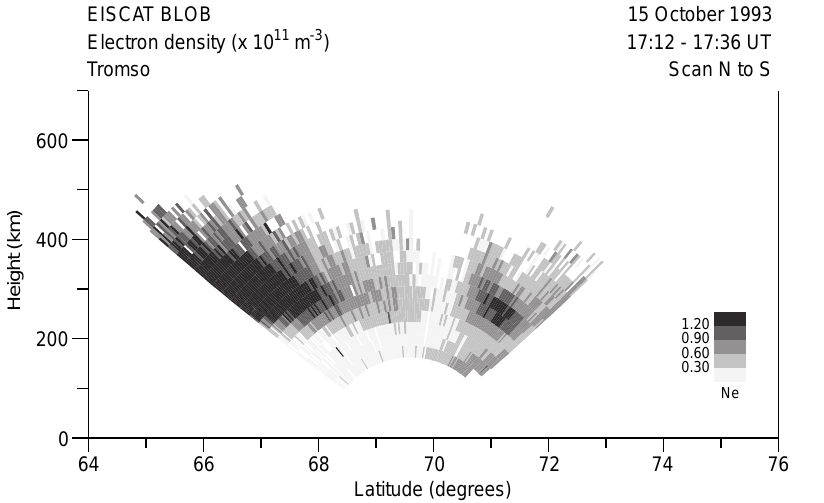
Fig. 1. Electron densities measured by the EI- SCAT radar during an initial scan of the SP- UK-BLOB program between 1712 and 1736 UT on 15